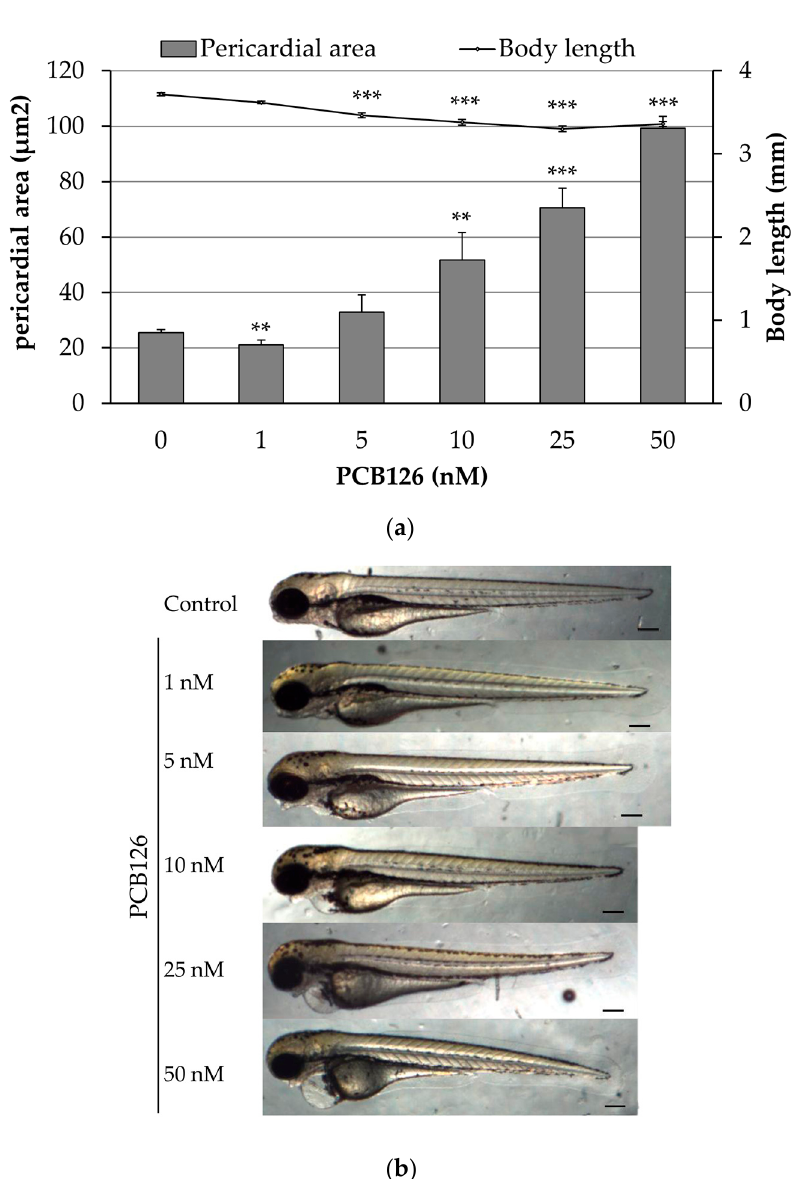
Figure 1. Concentration-dependent morphological effects of PCB126 exposure: ( a ) Mean pericardial sac area and body length of embryos exposed to increased concentration of PCB126. Values are mean ± SEM. Asterisks represent statistical significance at * p < 0.05, ** p < 0.01, and *** p < 0.001; n = 4 pools of five embryos (two biological replicates). ( b ) Representative images of embryos at 80 hpf exposed to increasing concentrations of PCB126 (Scale bar = 200 µm).